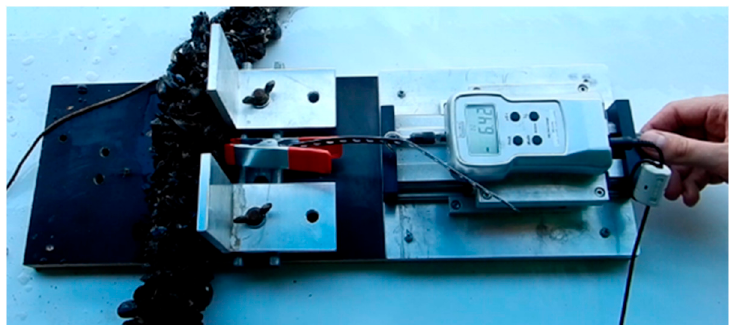
Figure 5. The attachment strength of an individual mussel to a line cutoff is measured with a force transducer.